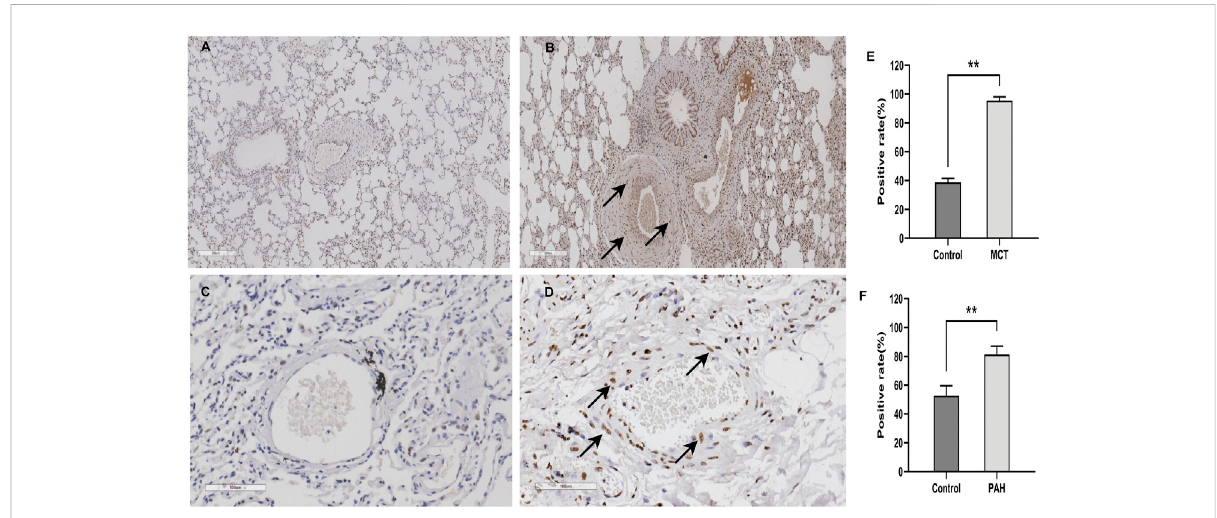
FIGURE 9 HNRNPA2B1 was highly expressedin thelung tissue of both MCT-PAH rat models and PAHpatients. (A,B) HNRNPA2B1 washighlyexpressedin theMCT-PAHlungtissue (B) comparedwithcontrols (A) ,asdeterminedusingIHC(×200). (C,D) HNRNPA2B1washighlyexpressedinthehumanPAH lung tissue (D) compared with healthy donors (C) , as determined using IHC (×200). (E,F) Quanti fi cation data was showed in E and (F) (** p ＜ 0.01).